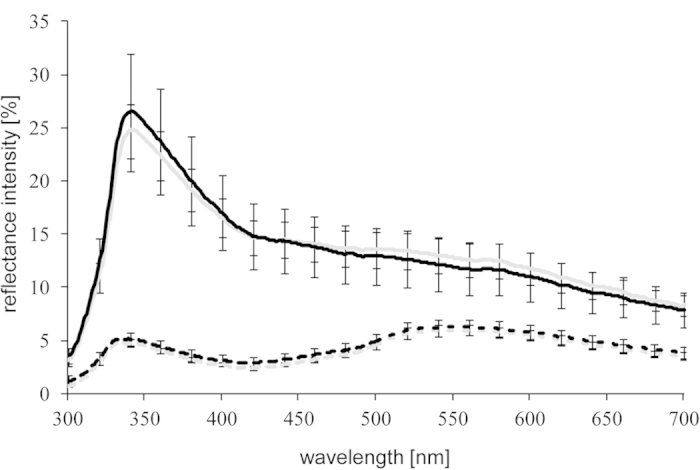
Reflectance spectra of body regions.Mean reflectance (proportion of light reflected in relation to a white standard (see text)) in the abdominal region (solid lines) and in the dorsal region (dashed lines) taken before (gray lines) and after (black lines) the presentation of a computer animation of a reproductively active male. Given are means ± standard errors.